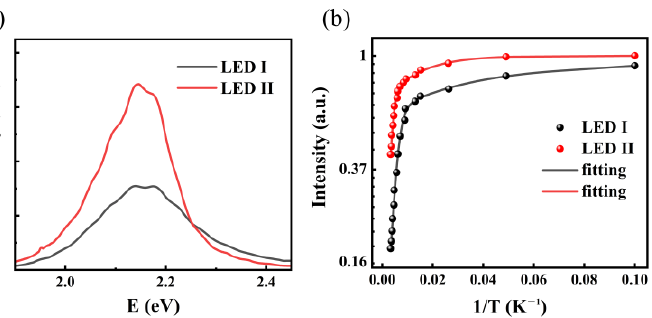
Figure 5. ( a ) PL spectra at room temperature for LED I and LED II. ( b ) Normalized integrated PL intensity as a function of 1/T for LED I and LED II, along with the Arrhenius fitting plots. To elucidate our finding, XRD measurements were performed to assess the non-radiative centers density existing in the two samples. It is acknowledged that the full width at half maximum (FWHM) of XRD ω -rocking curves for different planes could reflect the specific threading dislocation, including screw dislocation and the edge dislocation in the epitaxial structure. Figure 6a,b shows the XRD ω -rocking curves for (002) and (102) planes of two samples, respectively. We find that, in LED II, FWHMs of ω -rocking curves for both (002) and (102) planes are 147.50 and 243.18 arcsec, respectively, while they are 176.77 and 363.93 arcsec, respectively, in LED I. Threading dislocation density (TDD) in two samples is roughly estimated through the formula [31]: